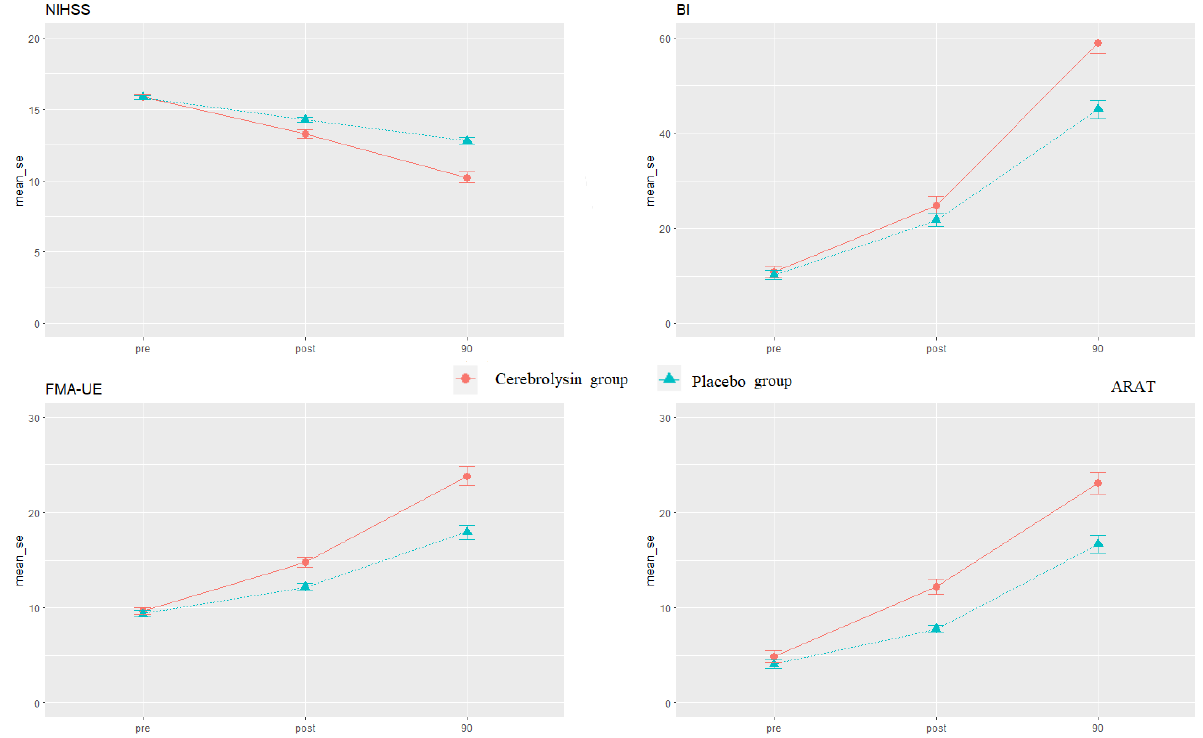
Figure 2. The interaction effect between time and therapy in NIHSS, FMA-UE, BI, and ARAT. The Y-axis represents mean values with error bars. The X-axis represents time points pre, post, and after 90 days.